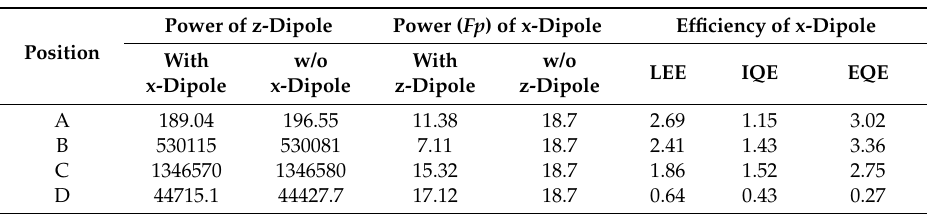
Table 1. Powers of z-dipole and x-dipole and efficiencies of x-dipole at different positions at 545 nm for Ag–PhC sample.